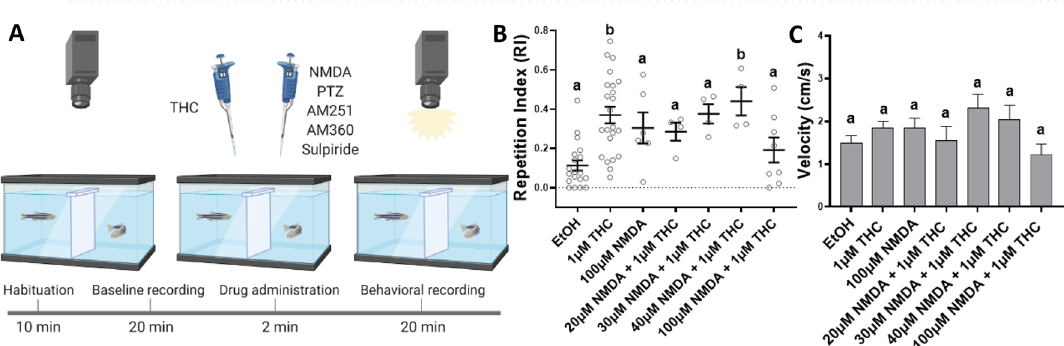
Figure 2. ( A ) Co-administration of Tetrahydrocannabinol (THC) and N-methyl-D-aspartate (NMDA) affects the THC-induced behavioral stereotypy in adult zebrafish. ( B ) At 100 μM NMDA with 1 μM THC the THC- induced Repetition Index (RI), calculated as a mean ± SEM, was not statistically different from the controls (EtOH) (ns p > 0.9999). ( C ) Nor did NMDA and THC co-administration affect the swimming velocity during exposure. Controls EtOH (0.0015%) (n = 19), 1 μM THC (n = 23), 100 μM NMDA (n = 6), 20 μM NMDA + 1 μM THC (n = 4), 30 μM NMDA + 1 μM THC (n = 4), 40 μM NMDA + 1 μM THC (n = 4) and 100 μM NMDA + 1 μM THC (n = 8). Mean RI values of 20 mM NMDA (n = 4), 30 mM NMDA (n = 4) and 40 mM NMDA (n = 4) were similar to 100 μM NMDA. Values without a letter in common are statistically different to the control condition ( p < 0.05, Kruskal–Wallis and Dunn’s multiple comparisons). Figure 2A was created with mean RI (** p = 0.0068, Dunn’s multiple comparisons test). At 100 μM NMDA and 1 μM THC, the behavior stereotypy was observed in 25% (n = 8) of the fish in comparison to 69.6% of fish at 1 μM THC alone. Moreover, none of the co-administrations of NMDA with 1 μM THC produced a significant change in velocity in com- parison to the ethanol controls (ns p = 0.0581, Kruskal-Wallis) (Fig. 2C). Data from 8 fish were excluded due to failed tracking, leaving data from 80 fish.